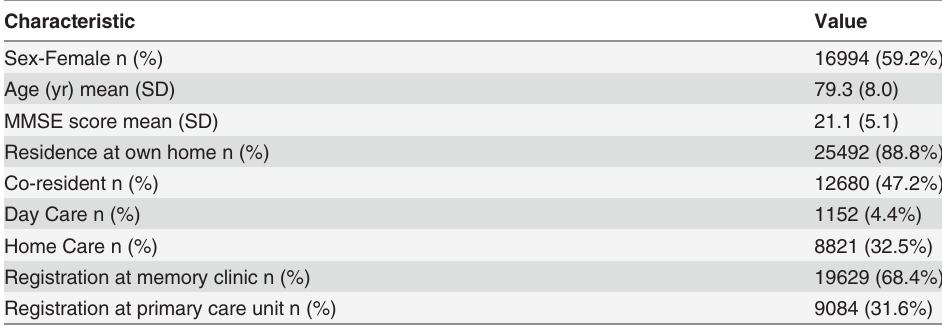
Table 2. Characteristics of the whole population of dementia patients registered in SveDem during 2007 – 2012 (n =